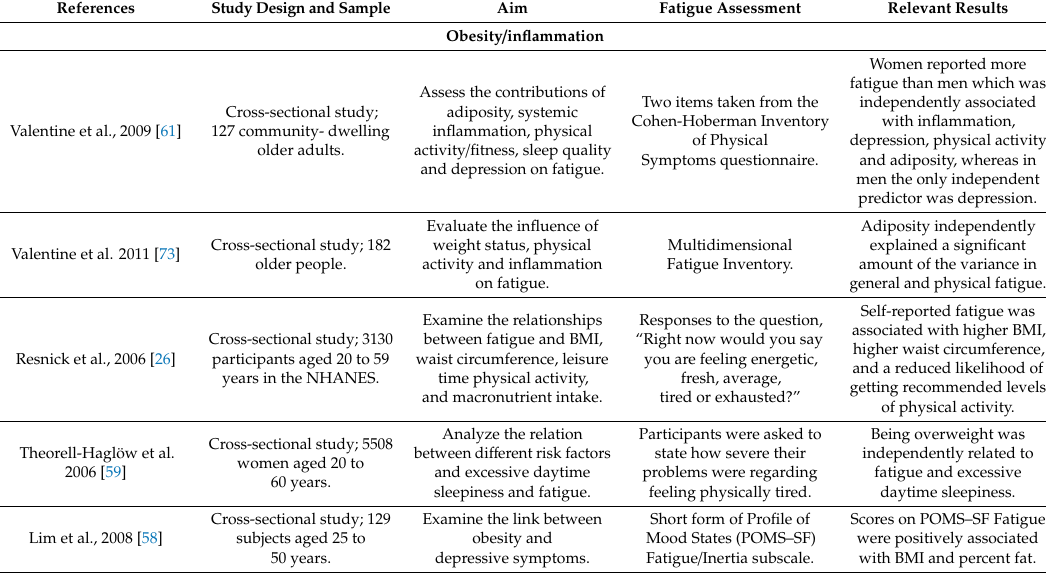
Table 2. Overview of discussed studies that explored relationships between fatigue and changes in body composition, inflammation and mitochondrial